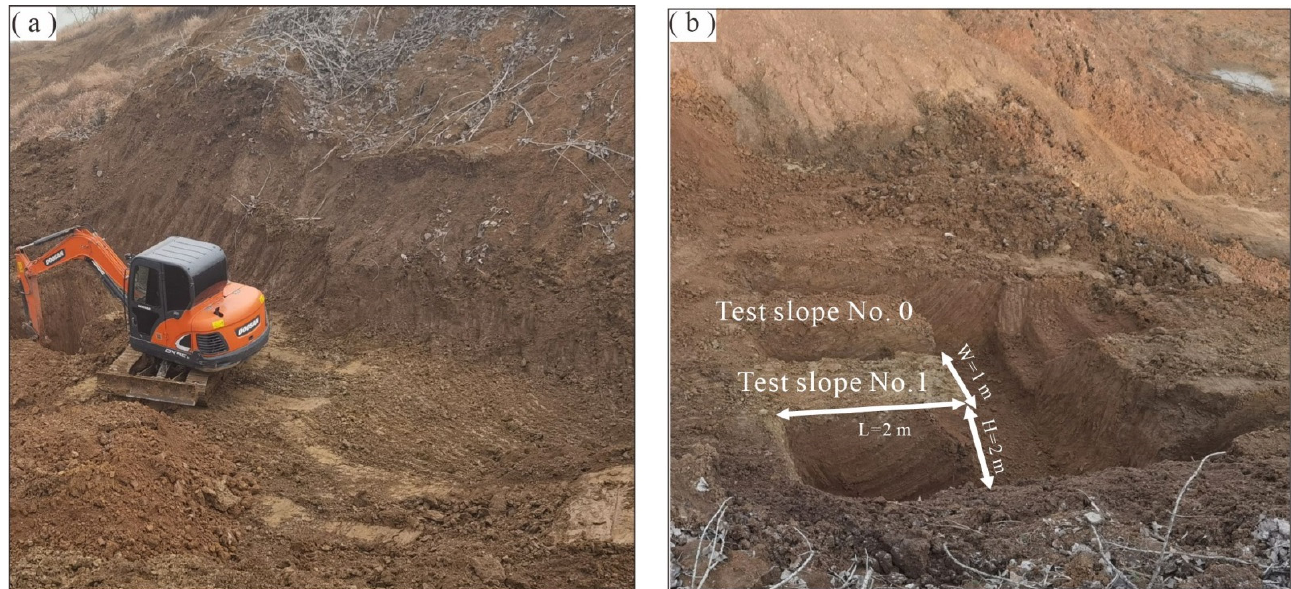
Figure 4. Test site preparation: ( a ) soil excavation; and ( b ) slope layout and size information.